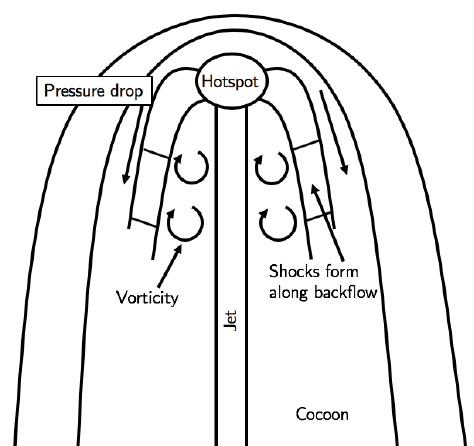
Figure 2: A schematic of the jet, hotspot, backflow and cocoon in a radio